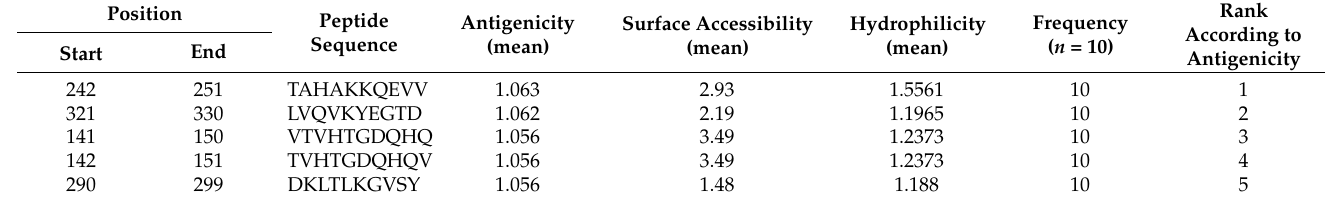
Table 1. Antigenicity, surface accessibility, hydrophilicity, and frequencies of top epitopes of DENV-1 E